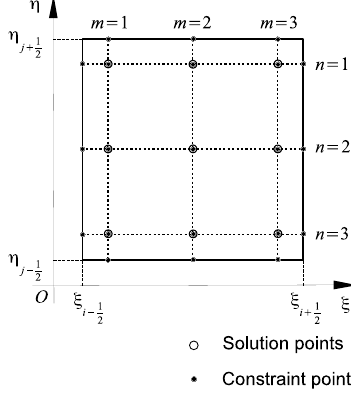
Figure 6. Configuration of DOFs and constraint conditions in a two- dimensional case.